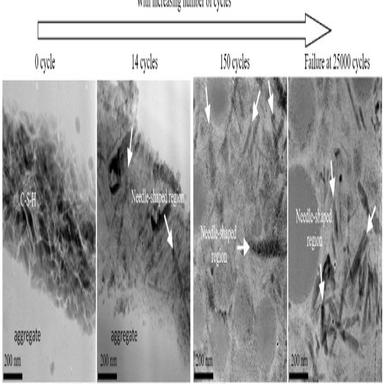
High-angle annular dark field STEM images of UHPC cement paste under the compressive fatigue loading adapted from.